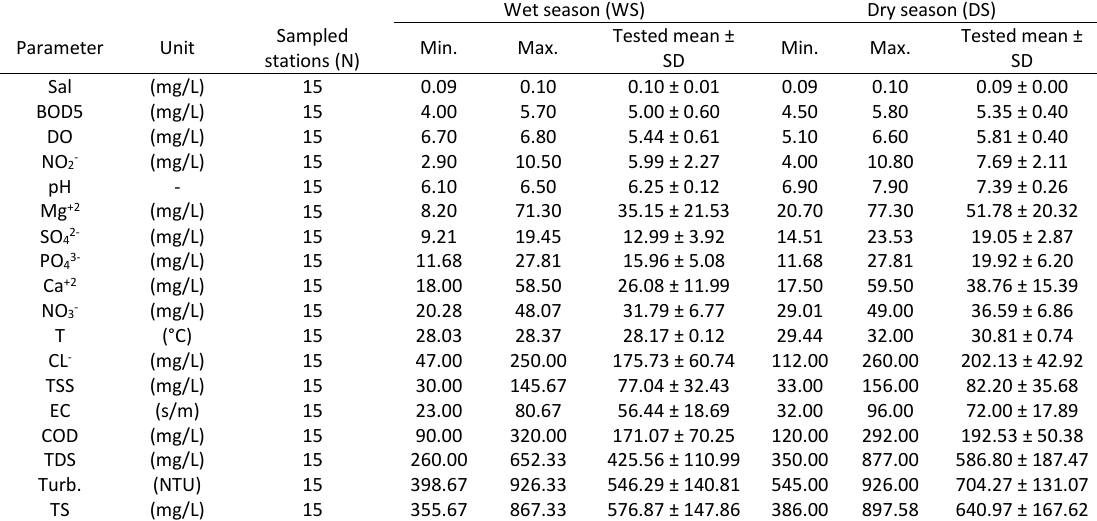
Table 2: Descriptive statistic of wet and dry season water quality parameters